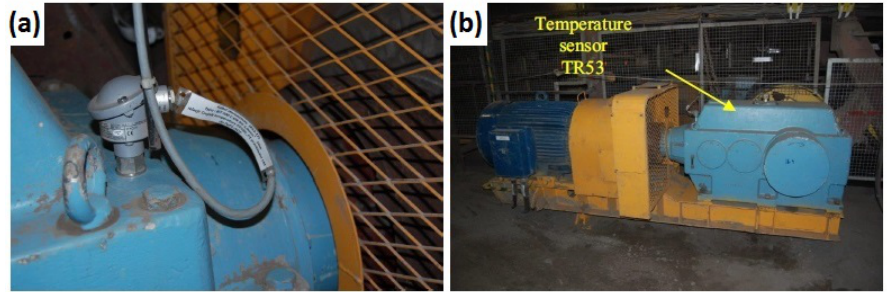
Figure 1. A belt conveyor drive: a temperature sensor location ( a ), an electric motor, a coupling and a gearbox ( b ).